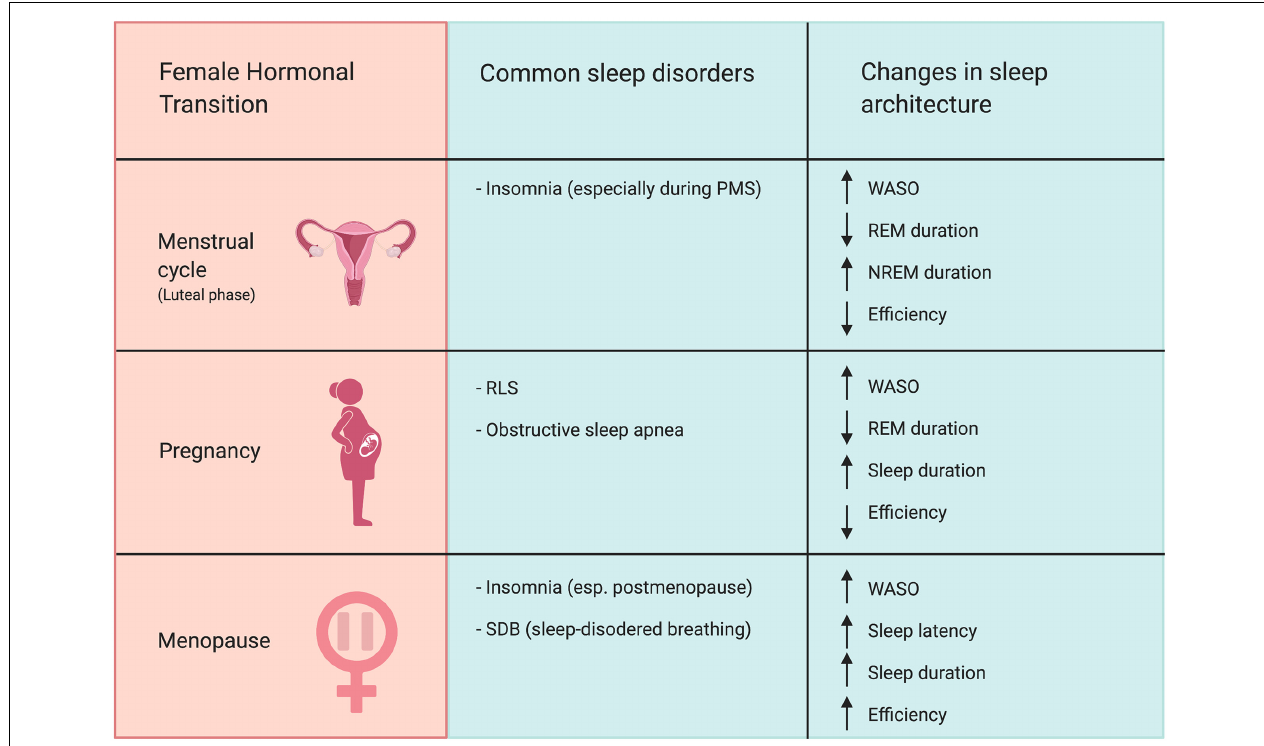
FIGURE 1 | Female hormonal transitions correspond with increased risk for sleep disorders and changes in sleep architecture. The luteal phase of the menstrual cycle, pregnancy, and menopause all increase prevalence of nocturnal awakenings. The luteal phase of the menstrual cycle is associated with increased risk for insomnia. Pregnancy, particularly the third trimester, increases risk of RLS and sleep apnea. The menopausal transition is associated with heightened prevalence of insomnia and SDB, particularly in postmenopause. Abbreviations: WASO, wake after sleep onset; REM, rapid-eye-movement sleep; NREM, non-rapid-eye-movement sleep; PMS, premenstrual syndrome; RLS, restless legs syndrome.